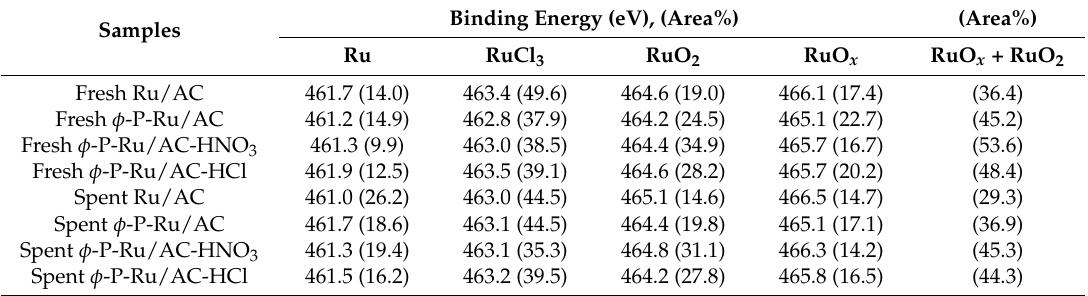
Table 3. The relative content and binding energy of ruthenium species in the fresh and spent catalysts.